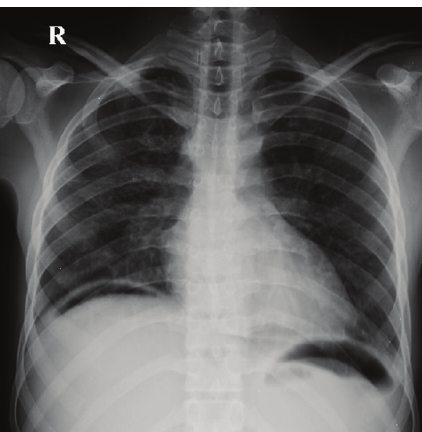
Figure 1: Erect CXR showing free air under the diaphragm.